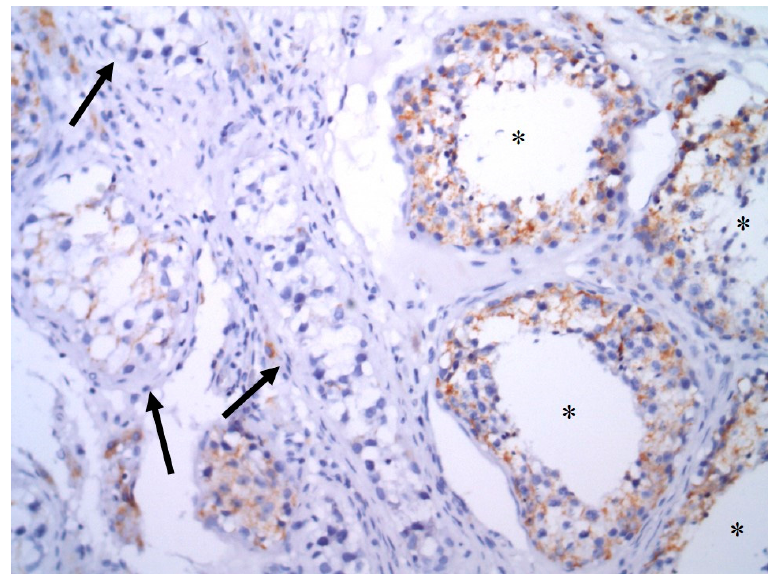
Figure 5. AIF expression in in spermatogenic cells of noncancerous testicular tissue (*) and in GCNIS (arrows) (immunoperoxidase technique, 200×).